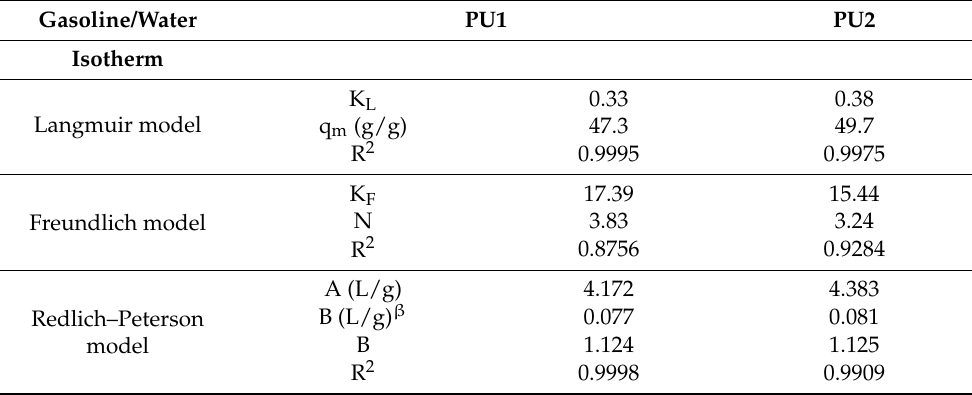
Figure 5. Langmuir and Redlich–Peterson models for the sorption of gasoline onto PU1 and PU2 ( a , b ) and for the sorption of diesel onto PU1 and PU2 ( c , d ). Table 3. Regression analysis of oil sorption by PU1 and PU2. Parameters estimated using Langmuir, Freundlich and Redlich–Peterson